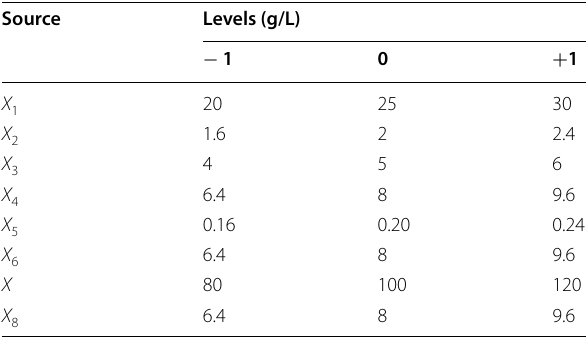
X 1 soybean powder, X 2 corn steep liquor, X 3 NaCl, X 4 NaNO 3 , X 5 KH 2 PO 4 , X 6 (NH 4 ) 2 SO 4 , X 7 glucose, X 8 CaCO 3